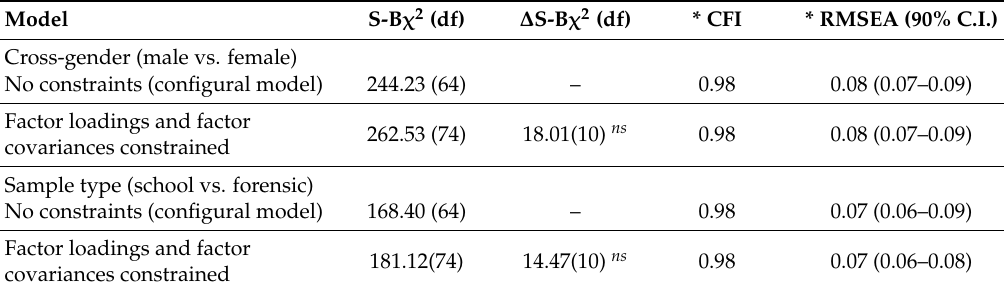
Table 2. Tests for invariance of the YPI goodness-of-fit